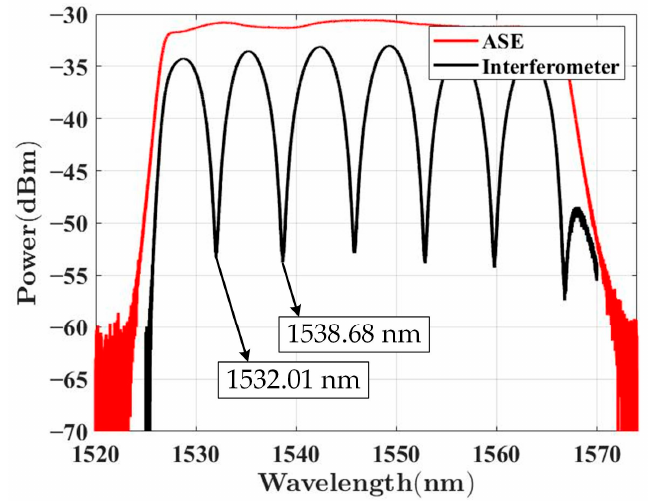
Figure A2. ASE light source spectrum and interferometer spectrum.